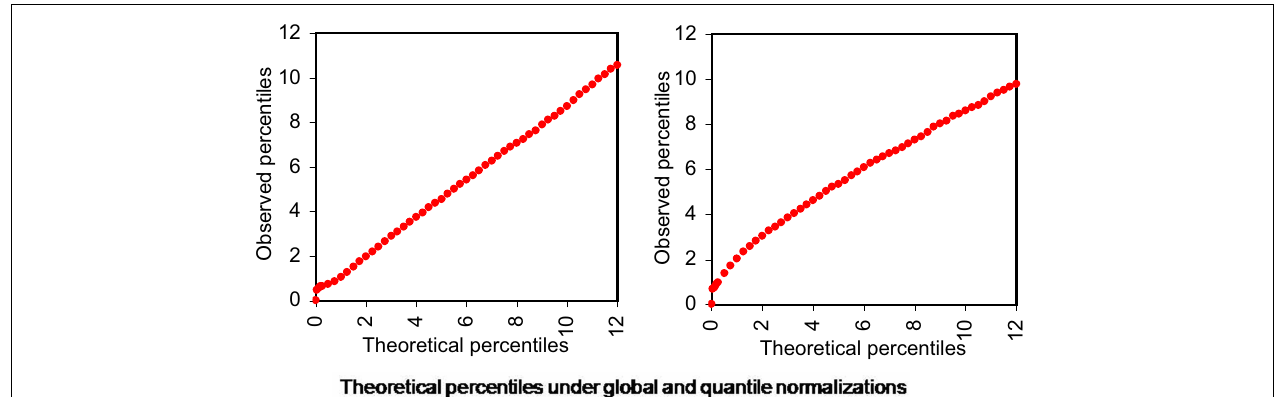
FIGURE 5 |Theoretical percentiles (in X -axes) and observed percentiles (in Y -axes) of overall isoform level expression variability parameters (across all six samples) under different normalizations. Left panel: global normalization, right panel: quantile normalization.